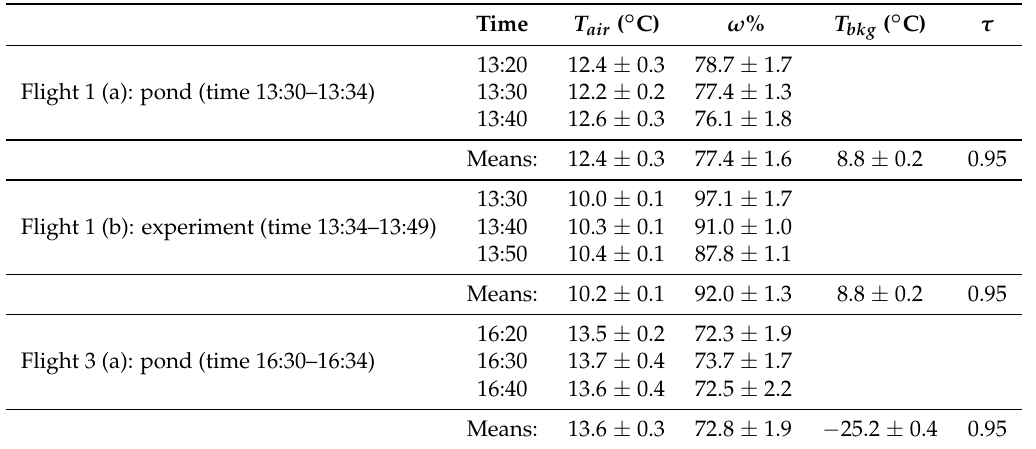
Table 3. Meteorological data as means from the weather station (a) and microclimatic station (b) during the flights on 11 April 2018 at 13:20–13:50 CET (flight 1) and 16:20–16:40 CET (flight 3). The background temperature ( T bkg ) and transmittance ( τ ) were used for atmospheric